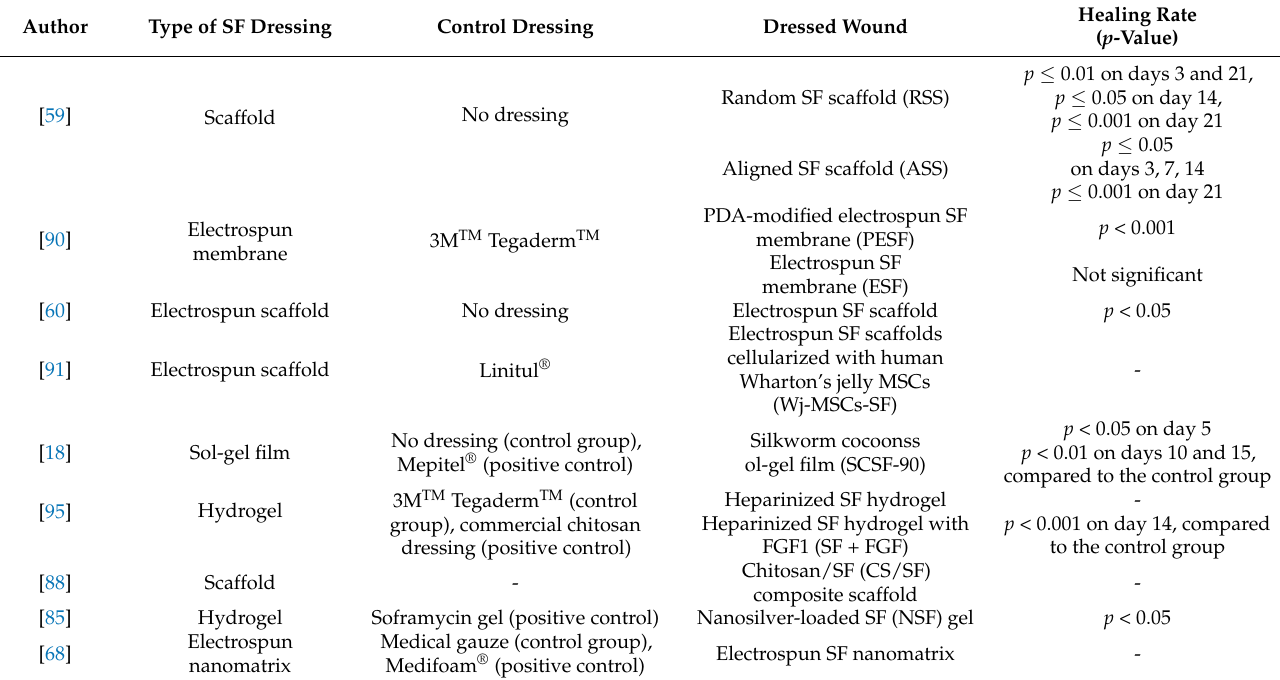
Table 1. Summary of SF biomaterials in skin wound